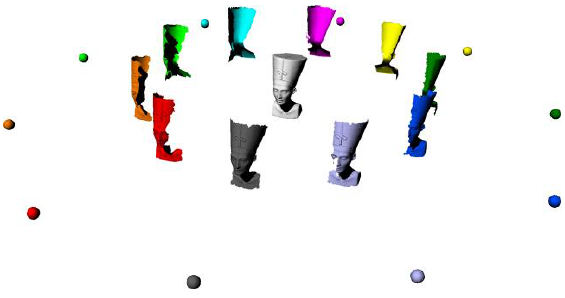
Figure 7. All potential viewpoints, captured surfaces and original model of interest.